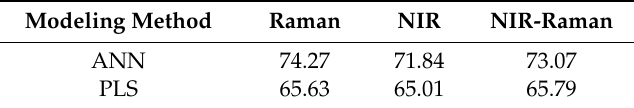
Table 4. Average f 2 value of the best artificial neural network (ANN) models compared to partial least squares (PLS) models using the same